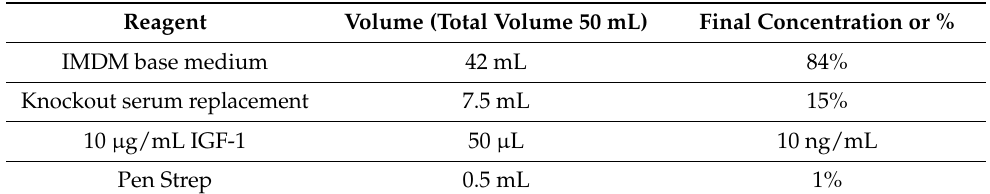
Table 7. Reagents needed to make 50 mL of MDM-III.